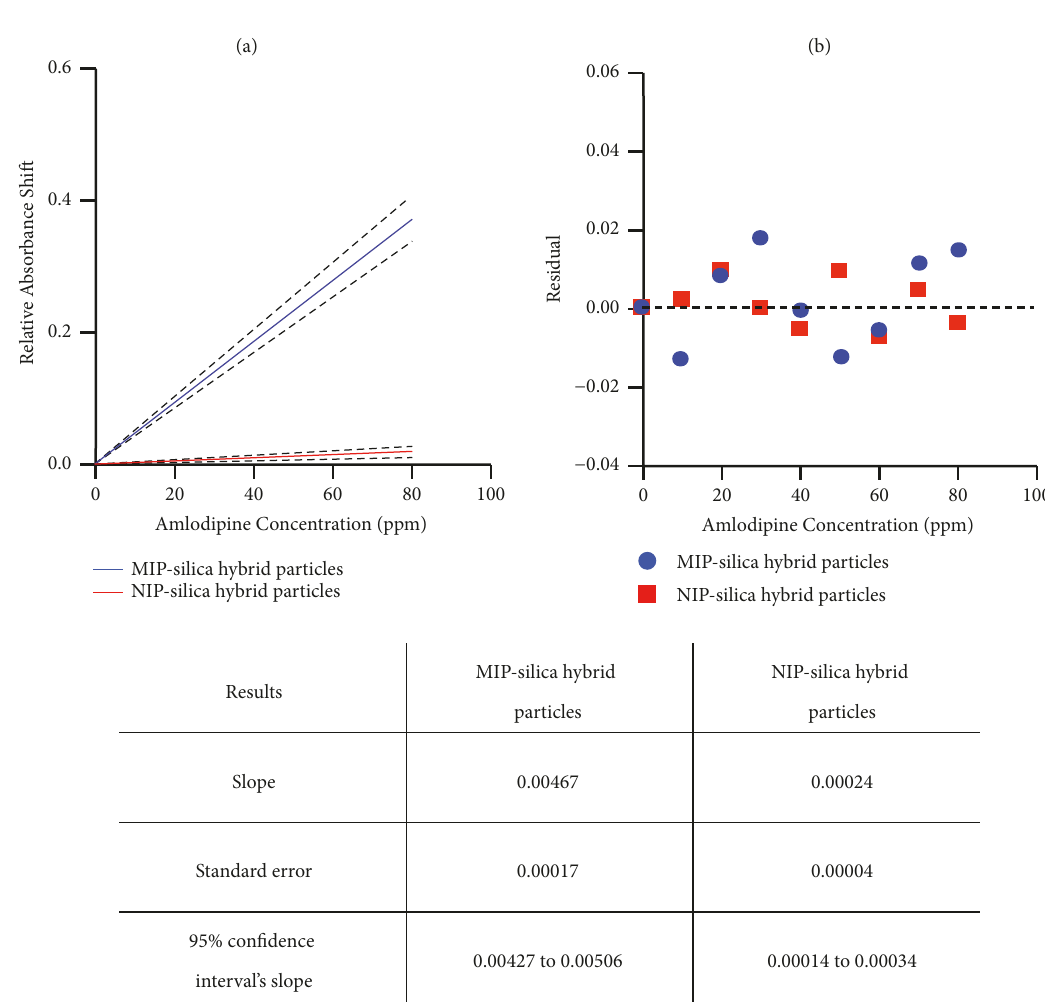
Figure 5: (a) A plot showing linear regression analysis of the absorbance data of MIP-silica hybrid and NIP-silica hybrid particles along with 95% confidence bands. (b) The residual plot showing the residuals distribution along the horizontal